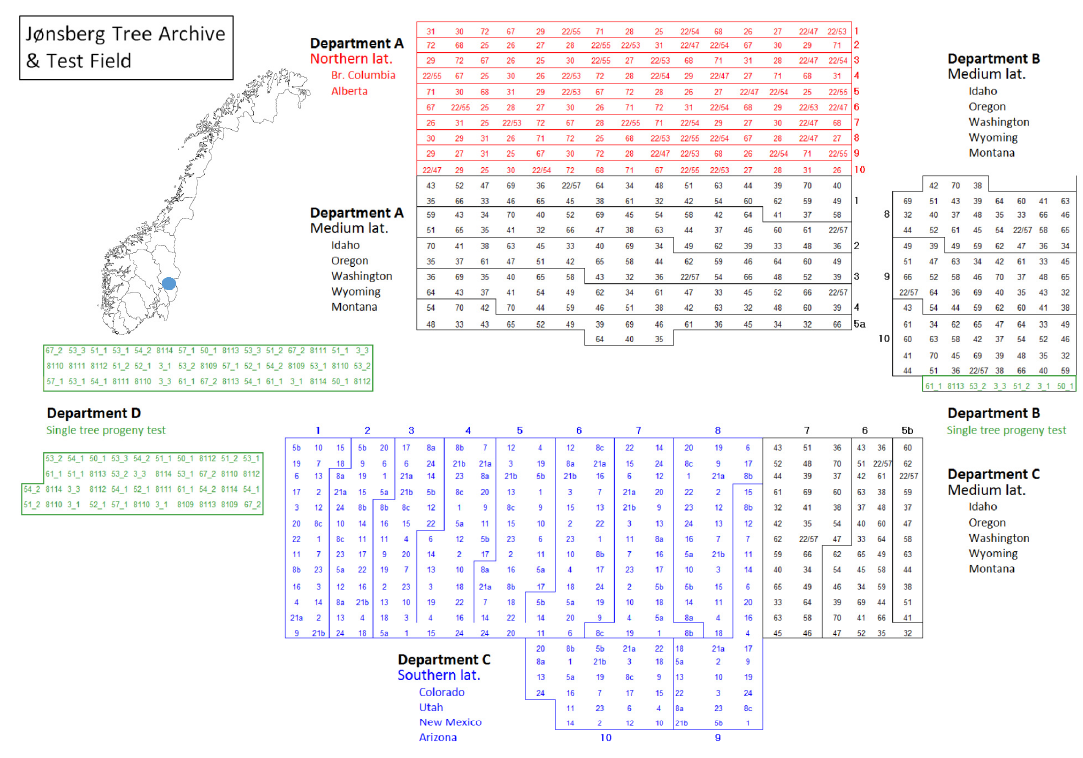
Figure 1. Outline of the provenance trial at Jønsberg. The three regions Northern latitude, Medium latitude, and Southern latitude are marked in red, black, and blue, respectively. The progeny tests in departments D and B (marked in green) were not included in this study. An inserted, small map of Norway indicates the area where Jønsberg is located (blue dot).